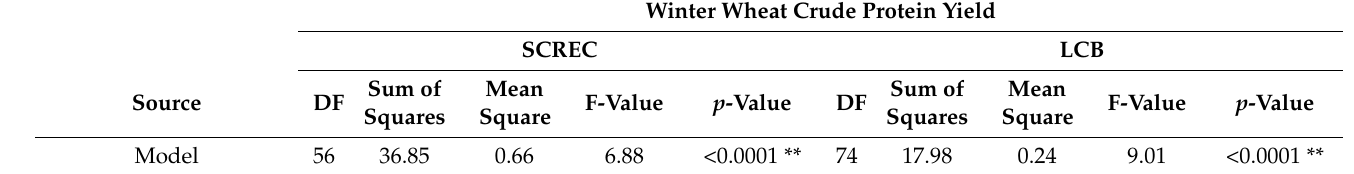
Table 5. ANOVA table with degrees of freedom (DF), sums of squares, mean squares, F -value, and p -value for each of the sources of variances for winter wheat crude protein yield at two locations in